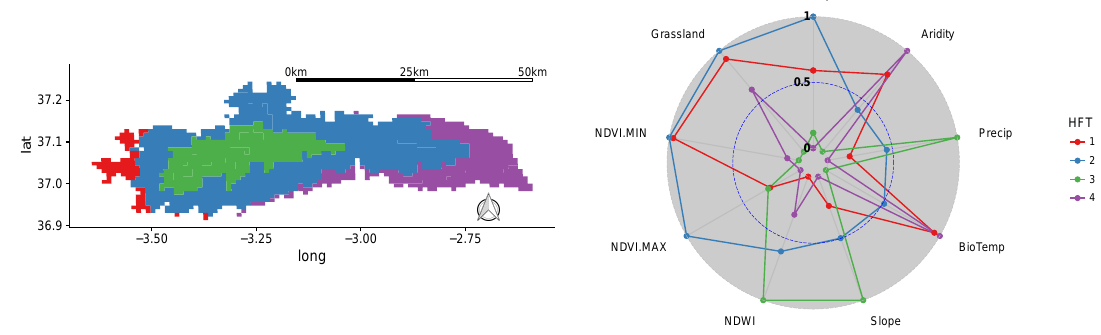
Figure 3. Map of habitat functional types (HFT) identified in the Sierra Nevada National Park and normalized mean values of the biophysical variables used (European Petroleum Survey Group—EPSG:4326). The description of the study variables can be found in Section